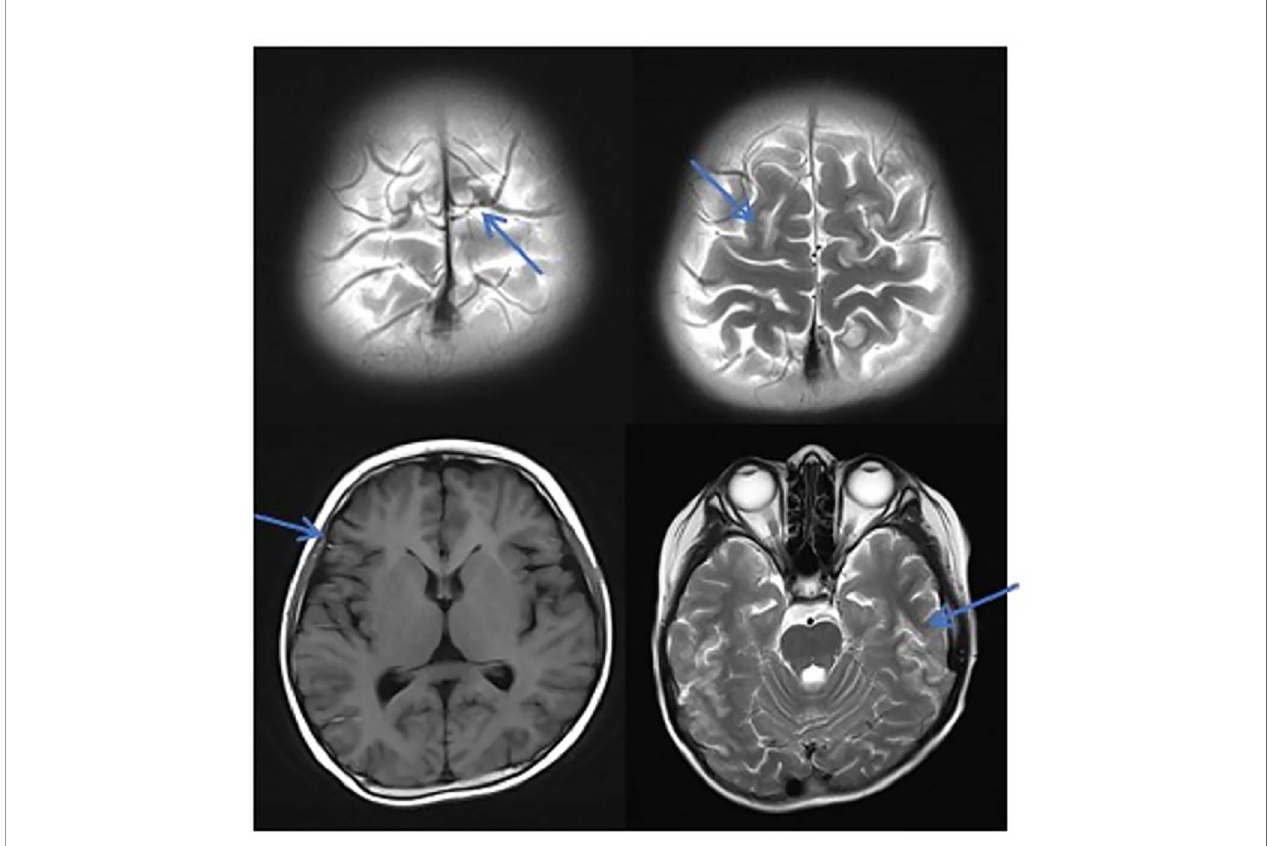
FIGURE 2 | MRI in patients with TA-TMA. Patients with TA-TMA showed bilateral frontal, parietal, and occipital sulcus edges with a sheet-like low signal on the T1WI, a slightly high signal on the T2WI, a FLAIR high signal, unclear borders, a bilateral parietal dotted DWI high signal, and unclear